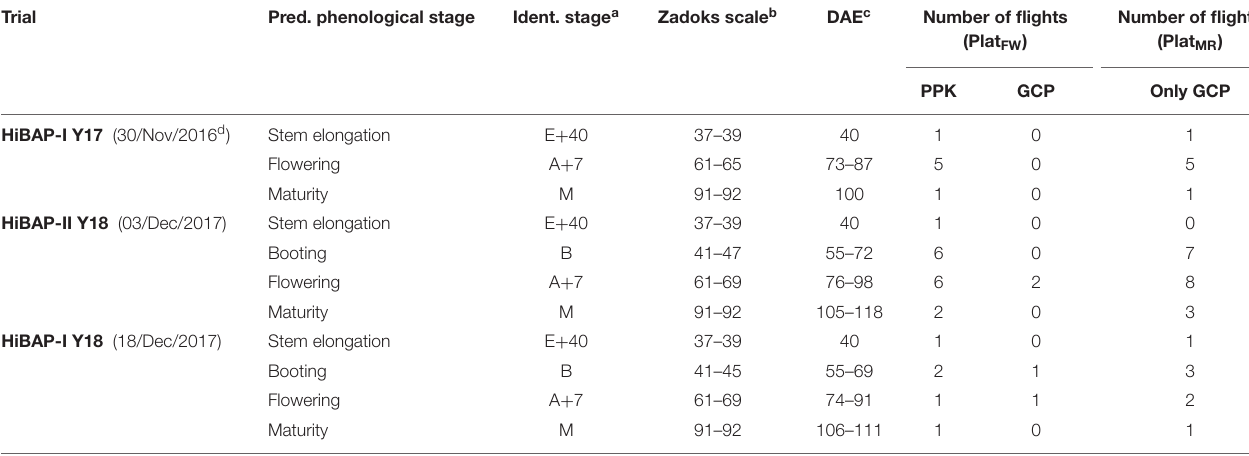
TABLE 2 | Crop phenology information across the measurements presented as days after emergence (DAE), the predominant development crop stage expressed by Zadoks growth scale, corresponding phenological stage and identification nomenclature in this investigation, as well as the number of flights for each platform using ground control points (GCPs) or post-processed kinematic (PPK) corrections for fixed-wing ( Plat FW ) and multi-rotor ( Plat MR ) platforms.